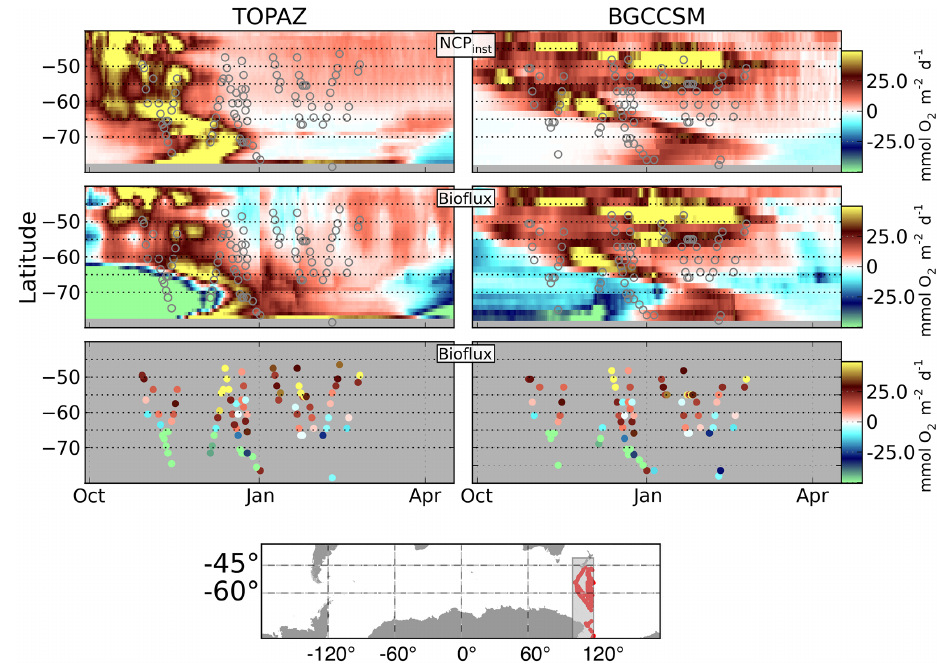
Figure 10. Hofmøller plots of model NCP (mmolm − 2 d − 1 , top panel), model O 2 bioflux (mmolm − 2 d − 1 , middle panel), and observed O 2 bioflux (mmolm − 2 d − 1 , bottom panel) in the Southern Ocean south of New Zealand (locations of observations are presented as red points on the map). All model values are zonal medians within the box. All observations that fall on a specific grid cell on a specific day of the year are averaged to one